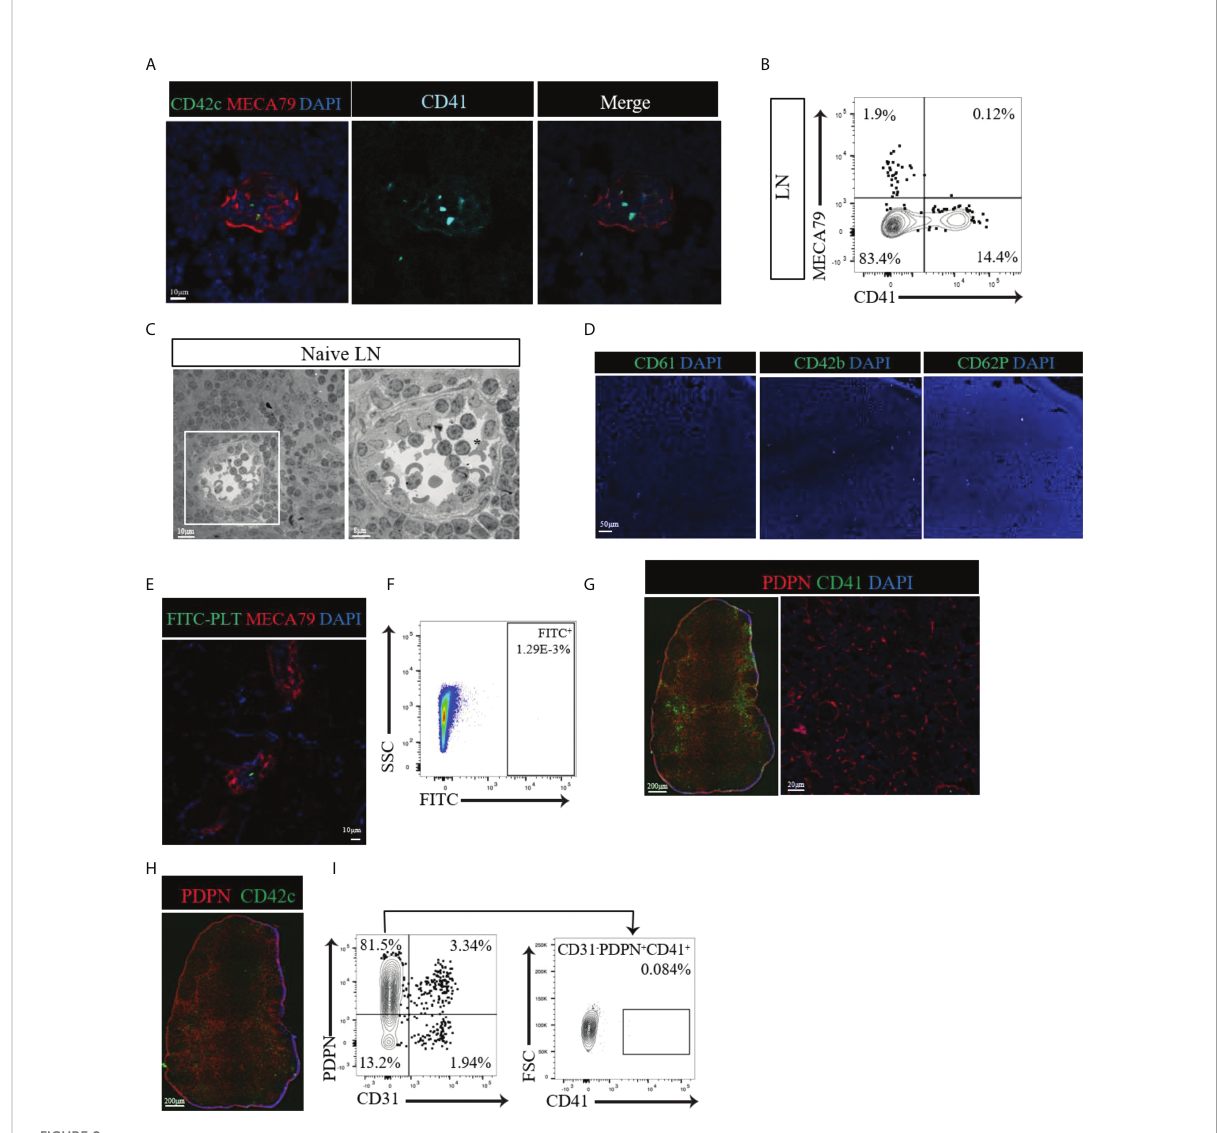
FIGURE 2 (A) Confocal images of naïve LNs labeled with CD41 (alcian blue), CD42c (green) and MECA79 (red). Typical CD41 + CD42c + platelets were observed only in the lumen of the HEV, not around the HEV. (B) Flow cytometry data showing no CD41 + PNAd + cells in naïve LNs. (C) Electron microscopic images of a naïve LN show platelets with granules (black asterisk) in the lumen of the HEV but not around the HEV. (D) A naïve LN stained for different platelet markers, such as CD61, CD42b, and CD62P, con fi rmed very few platelets. (E, F) Confocal imaging and fl ow cytometry assessment of LNs from mice injected with FITC-labeled platelets showed sparse populations of FITC-labeled platelets. (G) Immuno fl uorescence and confocal imaging of naïve LN showed no co-expression of CD41 and PDPN (red), CD41 (green) and DAPI (blue). (H) An immuno fl uorescence image of naïve LNs con fi rmed the presence of platelets in the blood vasculature and absence from the vicinity of lymphatic vessels and FRCs by staining for CD42c (green). (I) Flow cytometry assessment con fi rmed no CD41 + expression in the gated CD31 - PDPN + cell